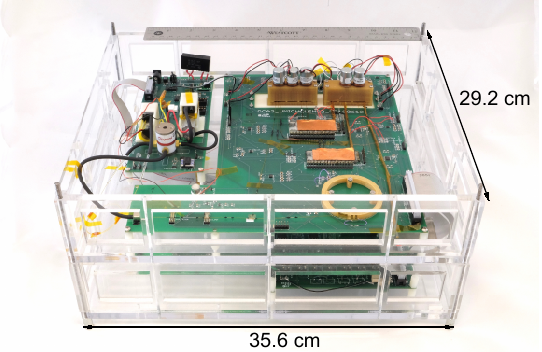
Figure 5. Photograph of the PCA3mv implementation. The PCA3mv subsystem has a footprint of 29.2 cm × 35.6